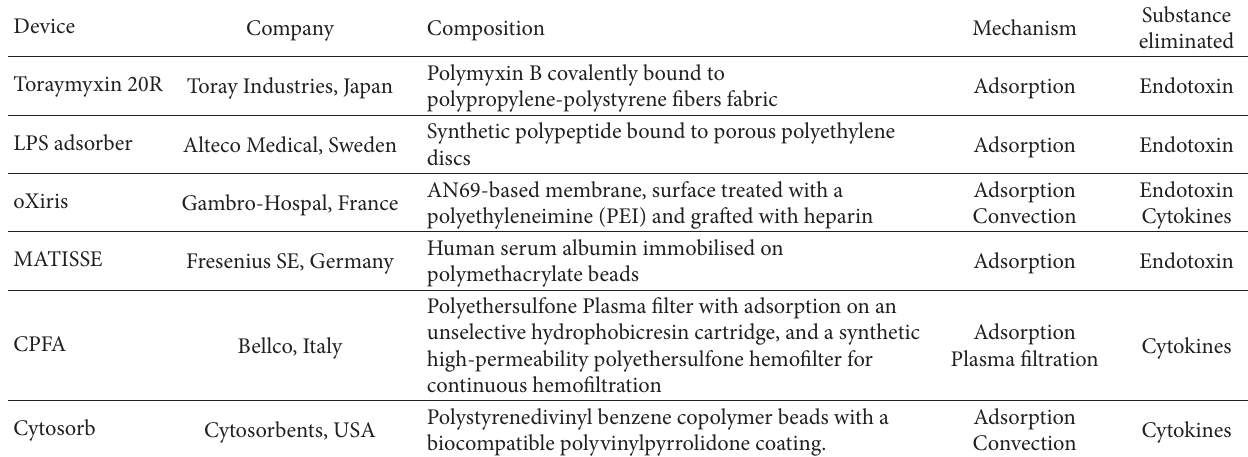
Table 1: Devices designed to remove endotoxin and cytokines in patients with septic